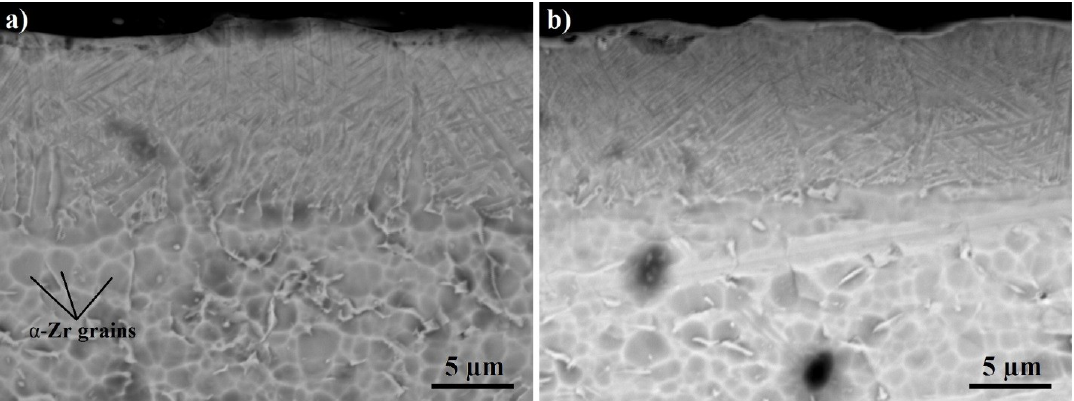
Figure 7. Cross-section SEM images of chemically etched Ti-implanted Zr-1Nb alloy ( a ) before and ( b ) after hydrogenation.